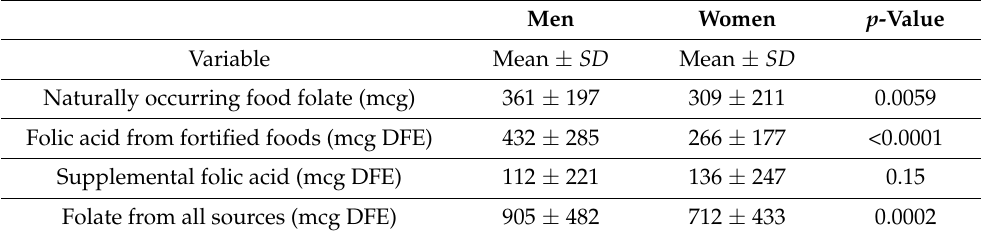
Table 2. Synthetic folic acid and naturally occurring food folate intake for male and female participants.